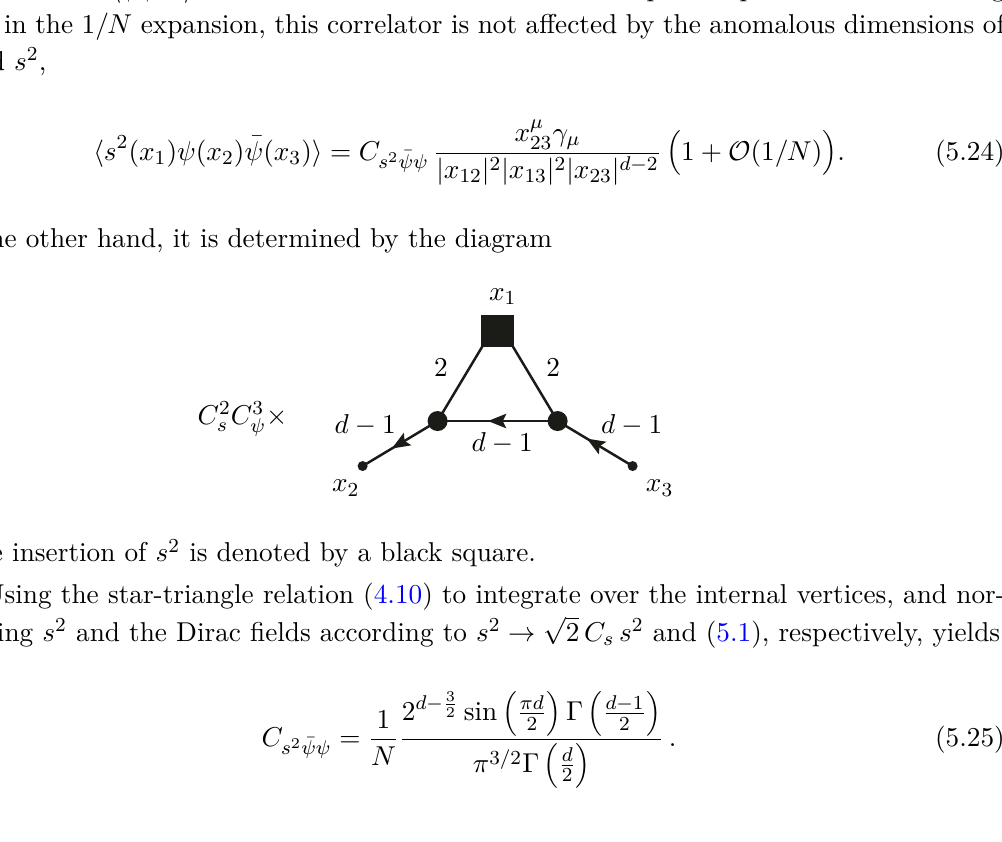
Figure 11 . The 1 /N correction to the OPE coefficient, W ¯ of space-time dimension 2 d 4 . The end points of the plot satisfy W ¯ ≤ ≤ W ¯ ( d = 4) = 3 ψψs −